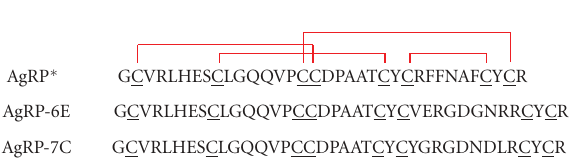
Table 1: Amino acid sequences of the AgRP ∗ mutants 7C and 6E used in this study. DOTA was site-specific conjugated to the N- terminal amine of these